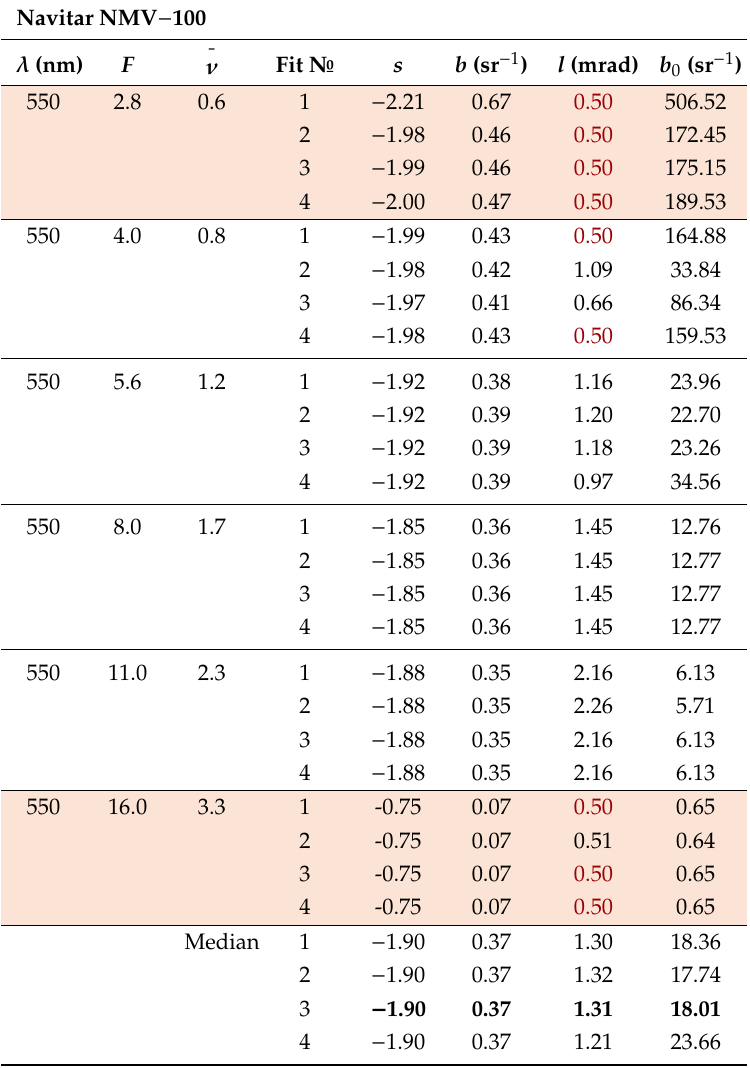
Table A6. Fit results for the lens Navitar